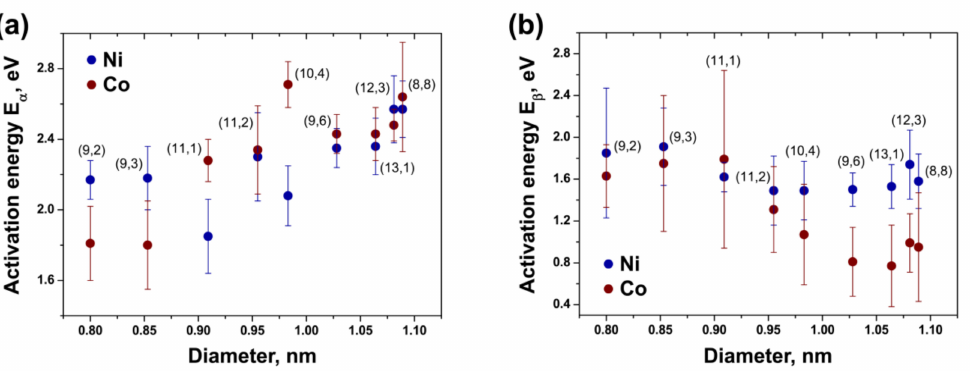
Figure 18. The comparison of the activation energies E α ( a ) and E β ( b ) of the growth of the inner tubes with the chiralities of (8,8), (12,3), (13,1), (9,6), (10,4), (11,2), (11,1), (9,3) and (9,2) upon in situ annealing of the nickelocene- and cobaltocene-filled SWCNTs plotted versus the tube diameter. The chiralities of inner tubes are denoted near the corresponding